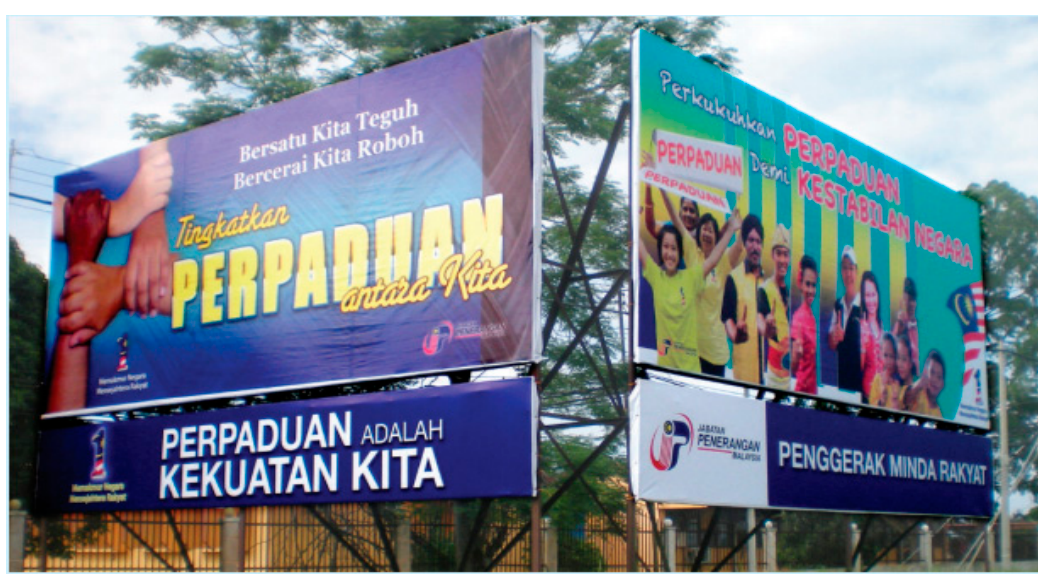
Figure 4. Some examples of multicultural values that reflect nation-building.